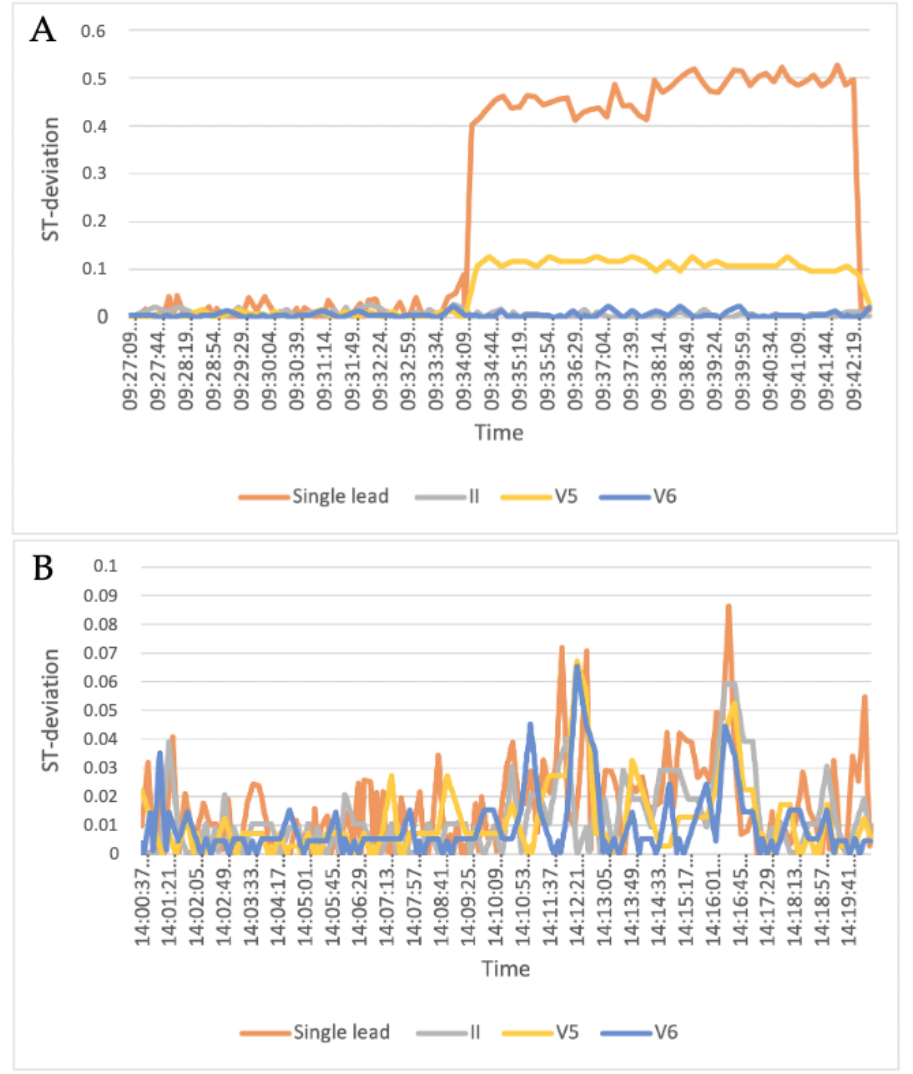
Figure 2. Examples of two patients’ ST-segment deviations during the adenosine cardiac stress test showing 12-lead II, V5 and V6 leads as well as the single-lead leads. ( A ) shows ST deviation > 0.1 mV in single lead and V5, whereas ( B ) does not show ST deviations > 0.1 mV in any recordings.